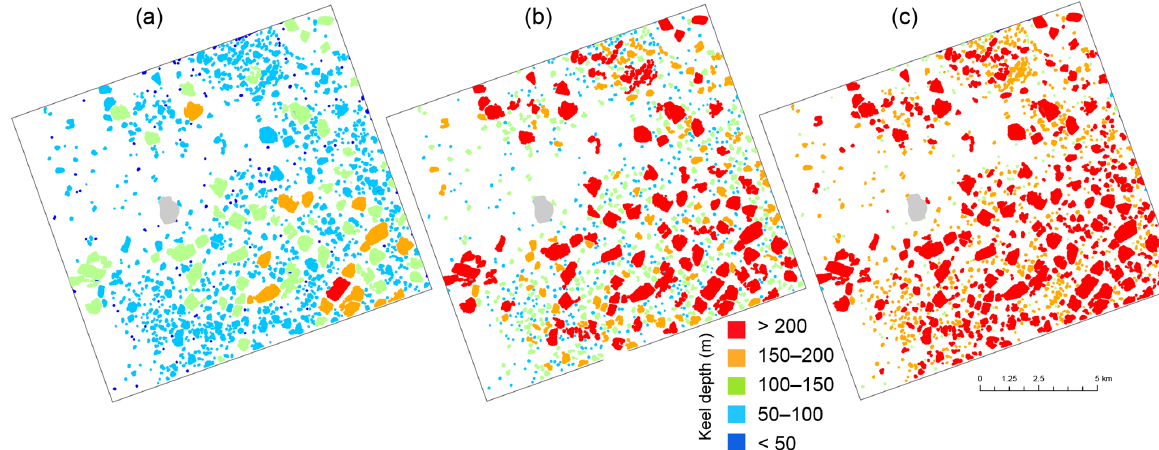
Figure 9. Derived minimum (a) , expected (b) , and maximum (c) keel